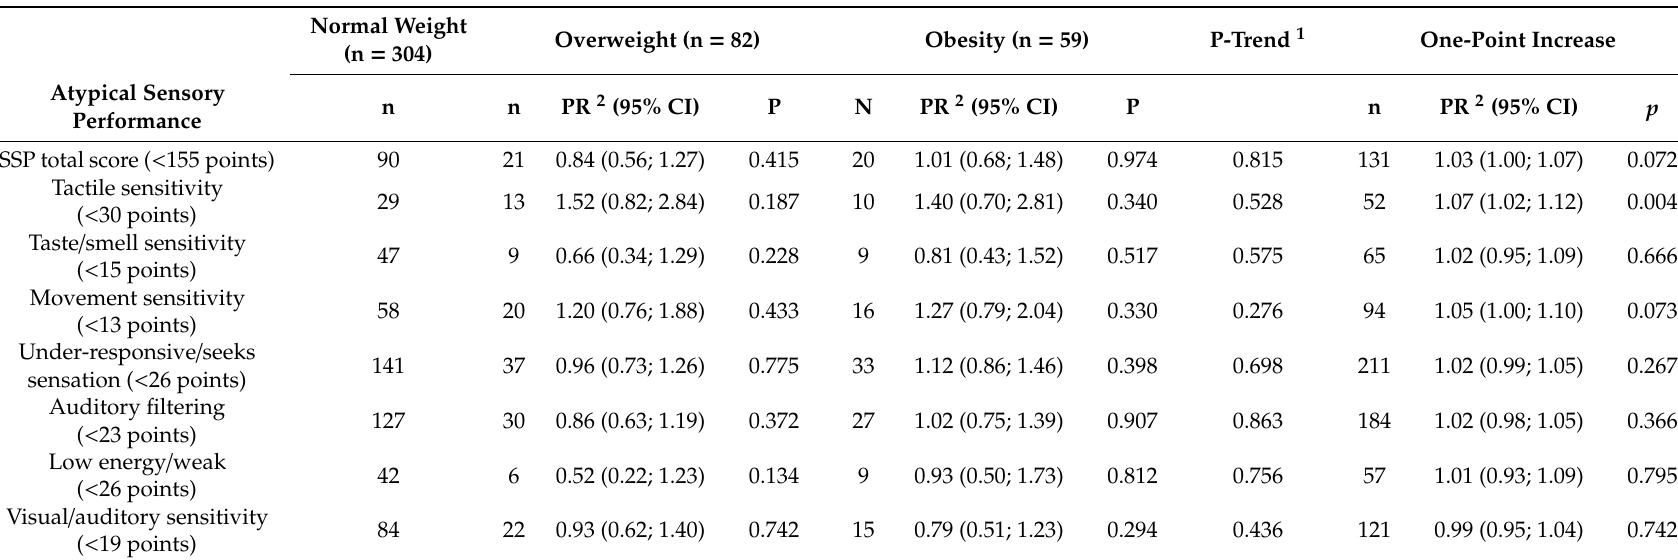
Table 2. Association between the body mass index (as a categorical and continuous variable) and the prevalence of atypical sensory processing using the total and subscales scores of SSP in children aged 3–7 years from InProS Project ( n =